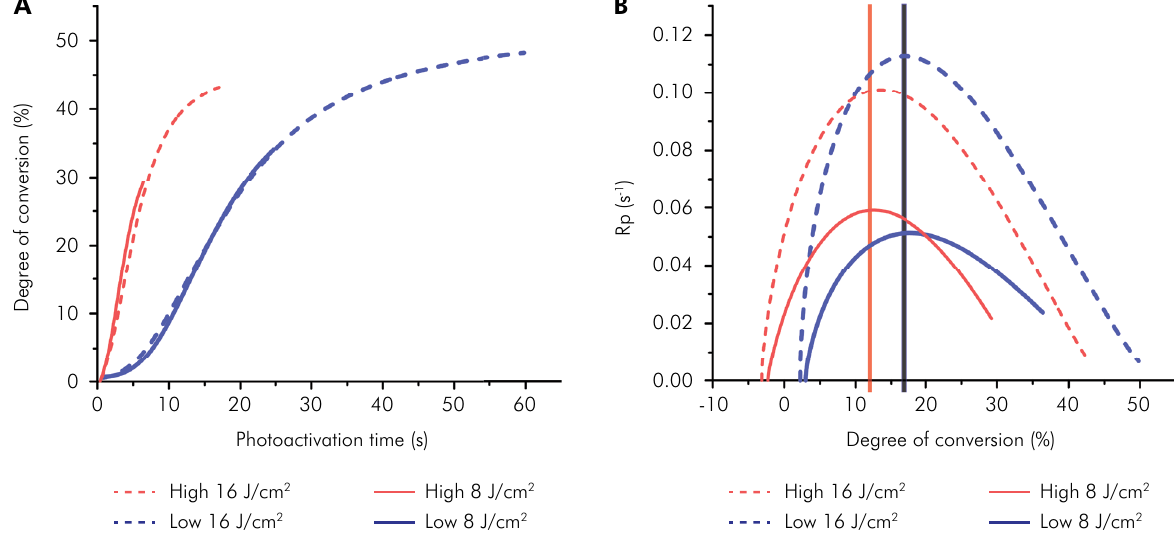
Figure 3. Degree of conversion (A) and polymerization rate as the functions of degree of conversion (B) of the different irradiance and radiant exposure parameters. Vertical lines at B show the point in conversion where Rp approaches the maximum and approximately corresponds to the material vitrification.